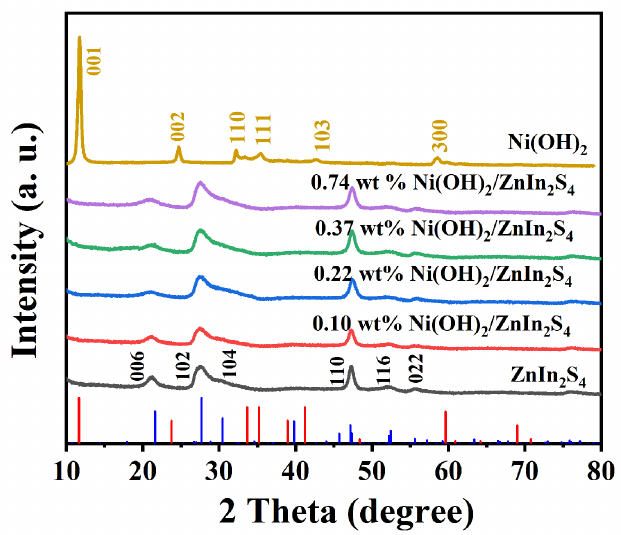
Figure 1. The XRD patterns of ZnIn 2 S 4 , Ni(OH) 2 , and Ni(OH) 2 /ZnIn 2 S 4 composites with different contents of Ni(OH) 2 (0.10 wt%, 0.22 wt%, 0.37 wt%, and 0.74 wt%). contents of Ni(OH) 2 (0.10 wt%, 0.22 wt%, 0.37 wt%, and 0.74 wt%).